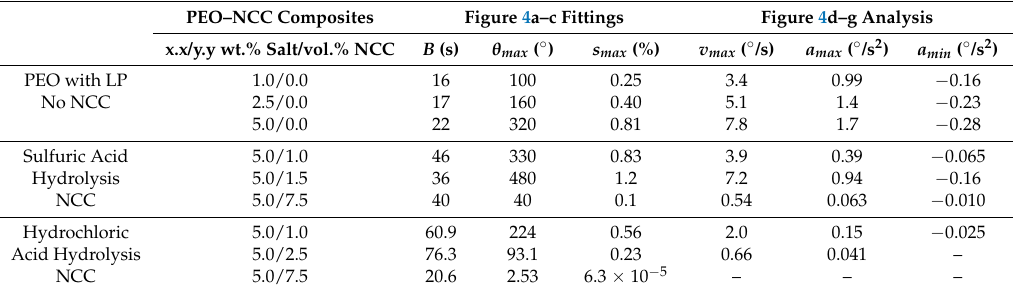
Table 2. Experimental fitting parameters for PEO IPMCs with varying concentrations of LP/NCC.